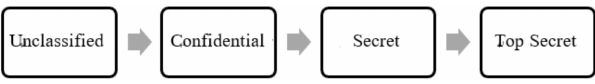
Figure 3. Four-layer security